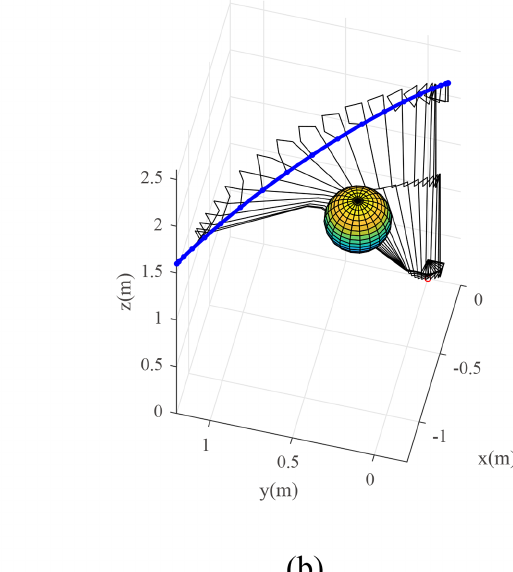
generated, and the trajectory of the end effector is cal- culated by Eq.